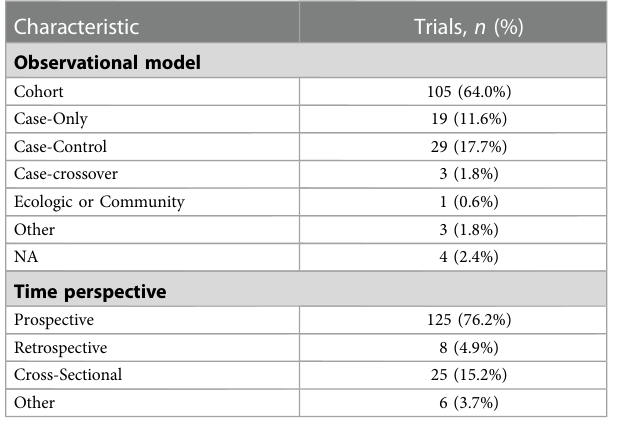
TABLE 2 The design of observational studies.